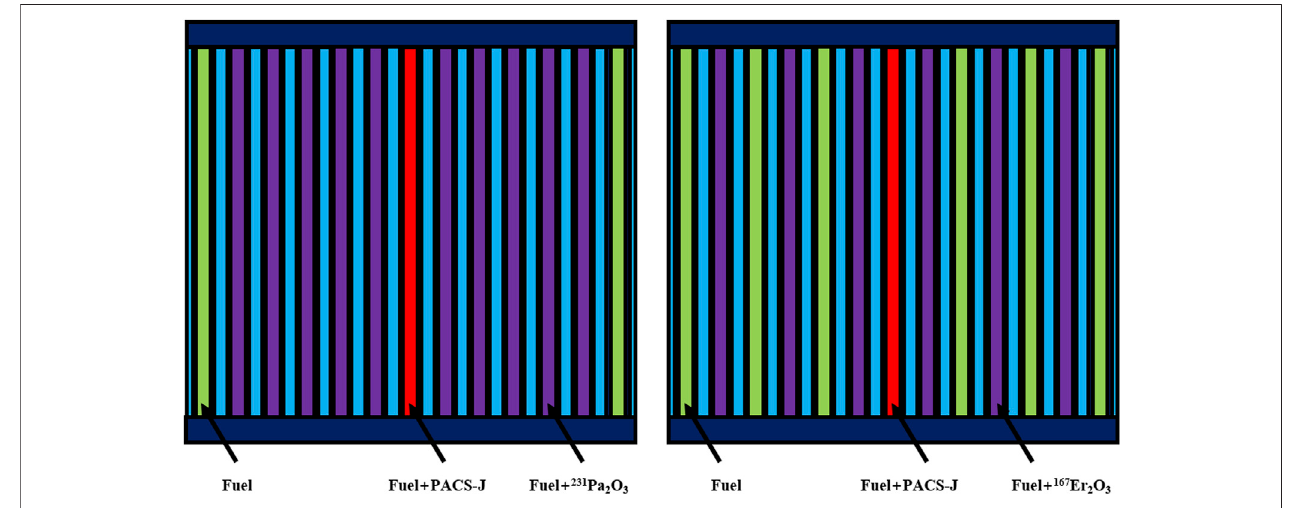
FIGURE 6 | Layout scheme of assembly with different numbers of burnable poisons.